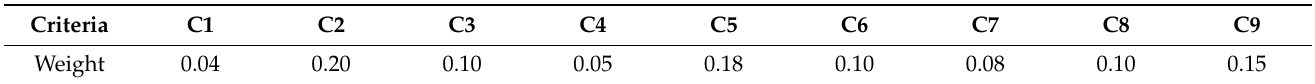
Table 2. Weights of the criteria.